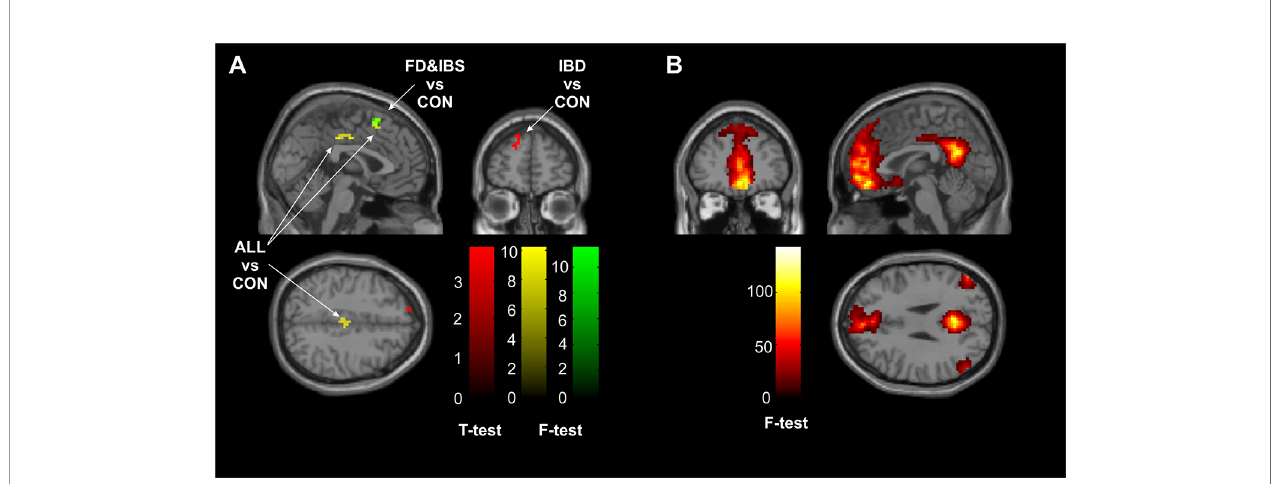
FIGURE 1 | (A) Signi fi cant (cluster corrected p FDR < .05) clusters of intergroup comparisons in contrast with the control group. The red cluster de fi nes area of additional DMN connectivity of the IBD group, the green cluster represents a region of auxiliary connectivity of the DMN shared by both FD and IBS groups, whereas the yellow clusters underpin regions of increased DMN connectivity shared by all of the gastrointestinal diseases. (B) A map of the main effect of the Default Mode Network as reconstructed during the Independent Component Analysis across all of the subjects — patients and controls combined (p FWE < 0.05). CON, the control group; FD, the functional dyspepsia group; IBS, the irritable bowel syndrome group; IBD, the in fl ammatory bowel disease group; ALL, all diseases (FD, IBS, and IBD).